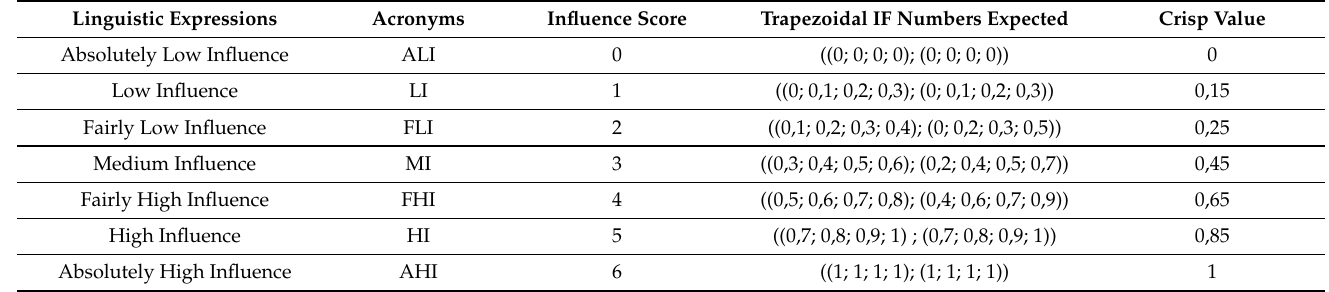
Table 2. Linguistic expressions values of Trapezoidal fuzzy numbers for linguistic terms [Adapted from [74]]. Linguistic Expressions